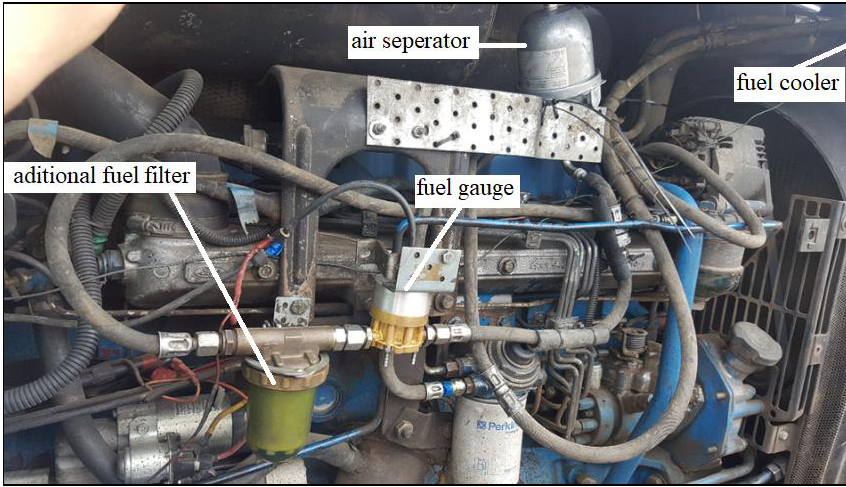
Figure 2. The additional technique to evaluate fuel consumption of tractor.